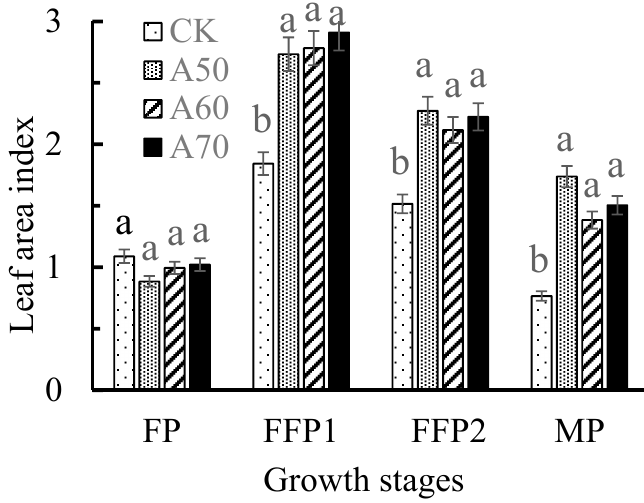
Figure 2. Leaf area index at different growth stages under alternate partial root-zone drip irrigation. Note: Different small letters mean significant difference ( p < 0.05 ) among the different treatments in same growth stage according to Duncan test. Flowering period (FP) was 0–50 d after tomato planting to field, Full fruit period I (FFP1) was 50–100 d after tomato planting to field, Full fruit period II (FFP2) was 100–140 d after tomato planting to field, and Mature period (MP) was 140–180 d after tomato planting to field.